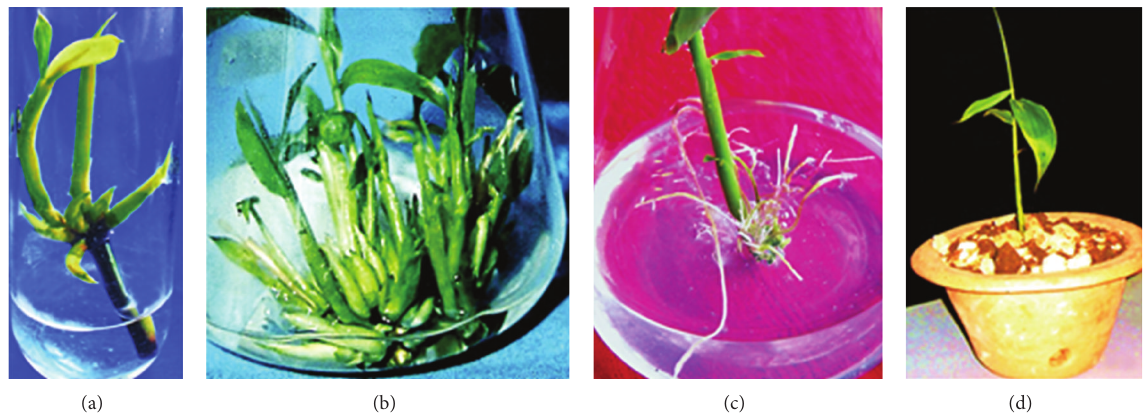
Figure 4: Micropropagation of M. baccifera . (a) Node with axillary bud breaks in liquid MS medium. (b) Shoot multiplication in 2 mg/L Kn + 3mg/L BAP. (c) Rooting in 0.5 MS medium supplemented with 3 mg/L IBA + 10 mg/L coumarin + 0.05 mg/L BAP + 3% sucrose. (d) Plantlets established in the soil under greenhouse